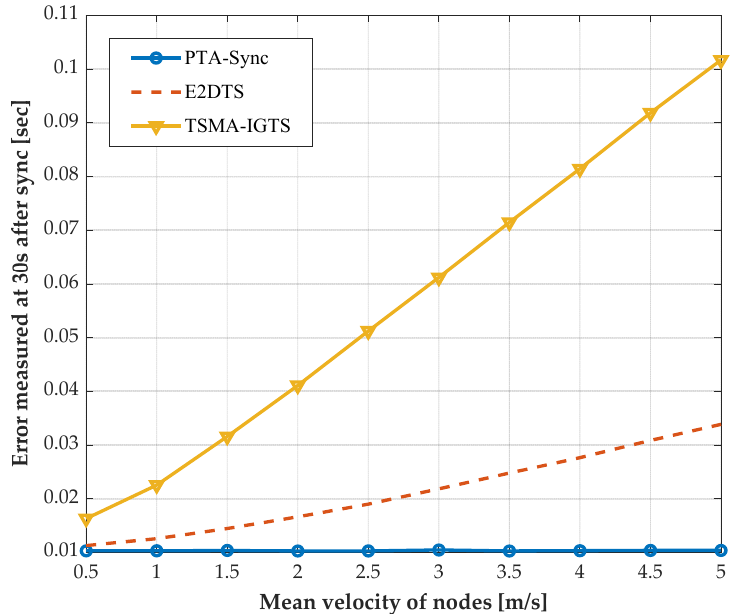
Figure 4. Time error measured at 30 s after synchronization versus V_mean when I_tx = 1.2 s, N_ex = 30, Nr = 15 km, T = 30 s, α =0.5.